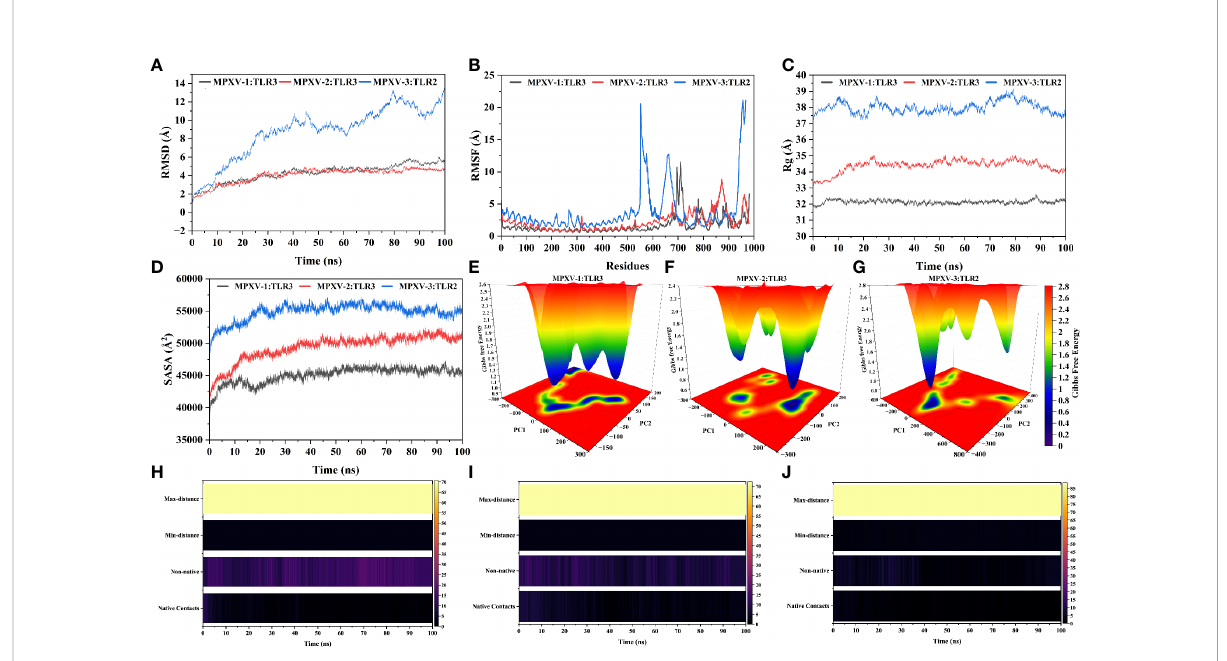
FIGURE 7 Molecular dynamics simulation of MPXV vaccines and TLR3/2 complex at 100ns (A) Root means square deviation (RMSD) plot of the complex, demonstrating slight fl uctuations (B) Root means square fl uctuation (RMSF) plot of the docked complex. TLR3 receptor starts at residue number 1 and goes to residue number 675. MPXV-1 starts at residue number 676 and goes to residue number 982. MPXV-2 starts at residue number 676 and goes to residue number 1064. TLR2 receptor starts at residue number 1 and goes to residue number 550. MPXV-3 start at residue number 551 and residue number 968 (C) Radius of Gyration plot of the docked complex (D) Variations in Solvent-Accessible Surface Area (SASA) pro fi le of the docked complex during the simulation. Free energy landscapes (FELs) of the (E) MPXV-1 – TLR3 (F) MPXV-2 – TLR3 (G) MPXV-3 – TLR2 docked complex. In the graph, red, yellow/green, and light-to-dark blue depicts high, intermediate, and low/stable energy states, respectively. Native and non-native contacts between (H) MPXV-1 – TLR3 (I) MPXV-2 – TLR3 (J) MPXV-3 – TLR2 interface during